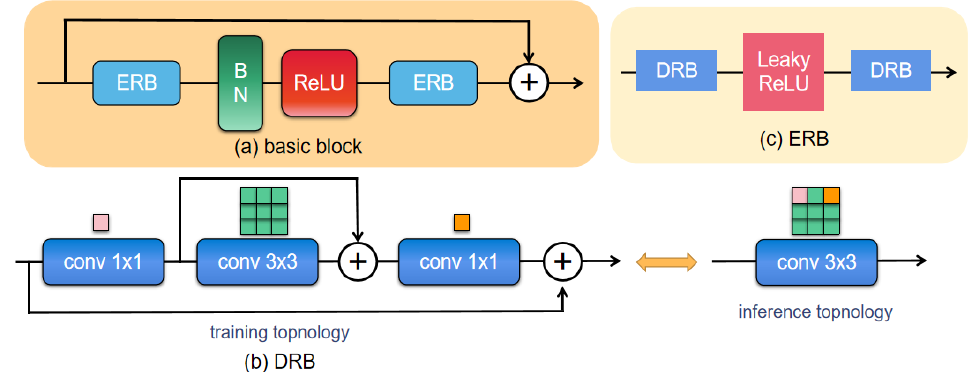
Figure 3. ( a ) The structure of the basic block in the encoder. ( b ) Structure of DRB, which consists of three convolutional layers, equivalent to a 3 × 3 convolutional layer during inference; ( c ) ERB, which consists of two